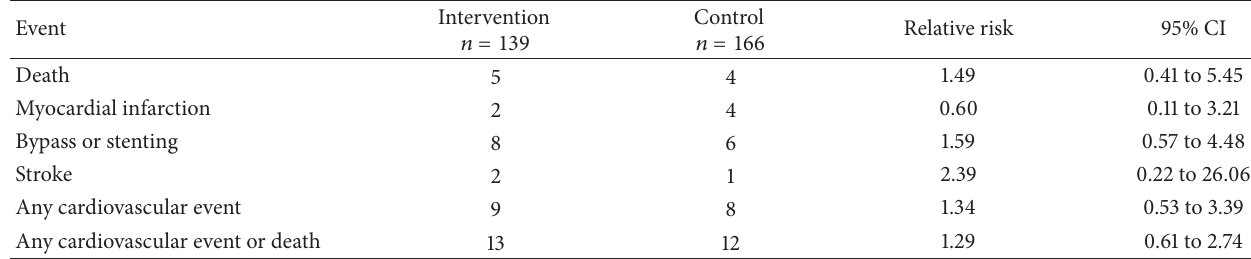
Table 5: Cardiovascular events and